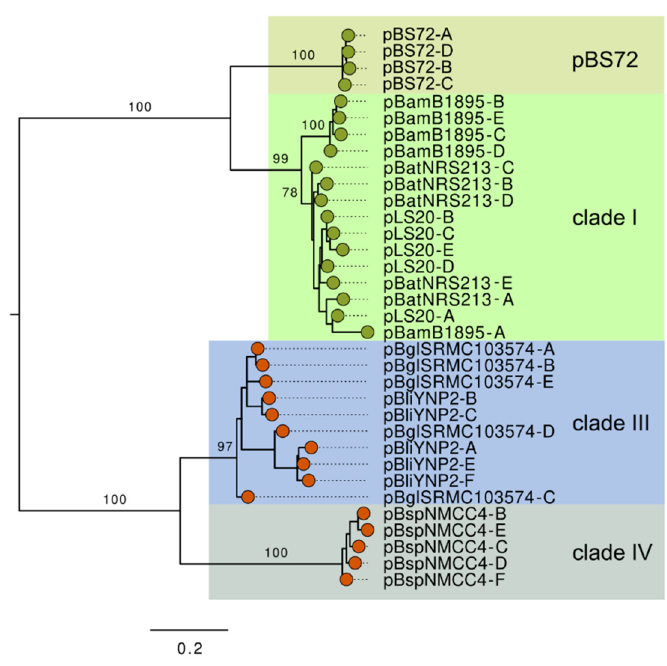
Figure 4. Phylogenetic relatedness of EGeRS1 sequences present on the reference plasmids belonging to pLS20 family clades I, III, IV, and plasmid pBS72. Phylogenetic trees were constructed for the